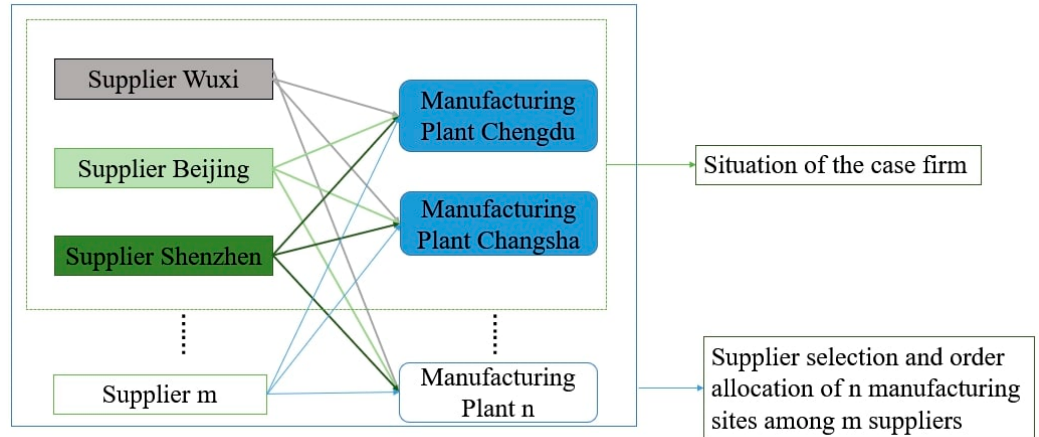
Figure 3. The description of the supplier selection and order allocation issues.